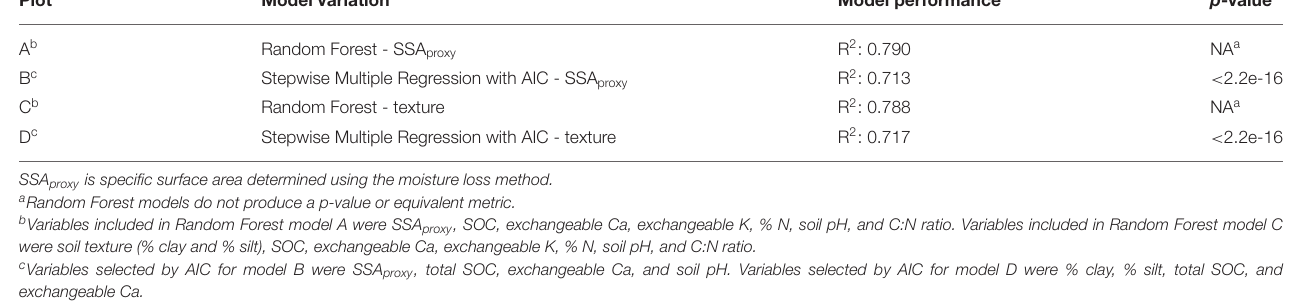
TABLE 1 | Model performance metrics for MAOC estimation. Plot